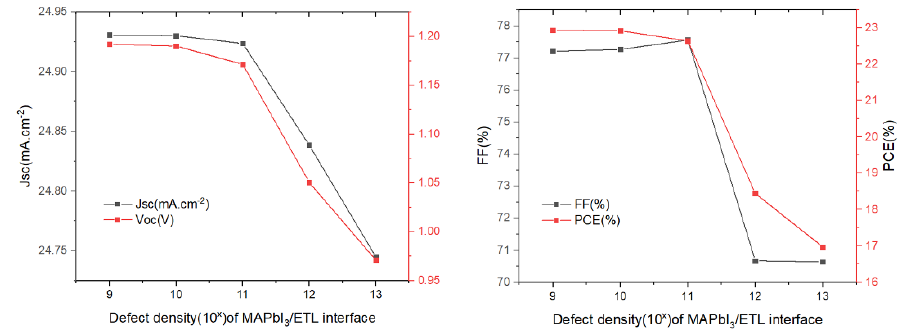
Figure 9. Influence of the MAPbI 3 /SnO 2 interface defect density on the photovoltaic parameters ( V oc , J sc , FF , and PCE ).